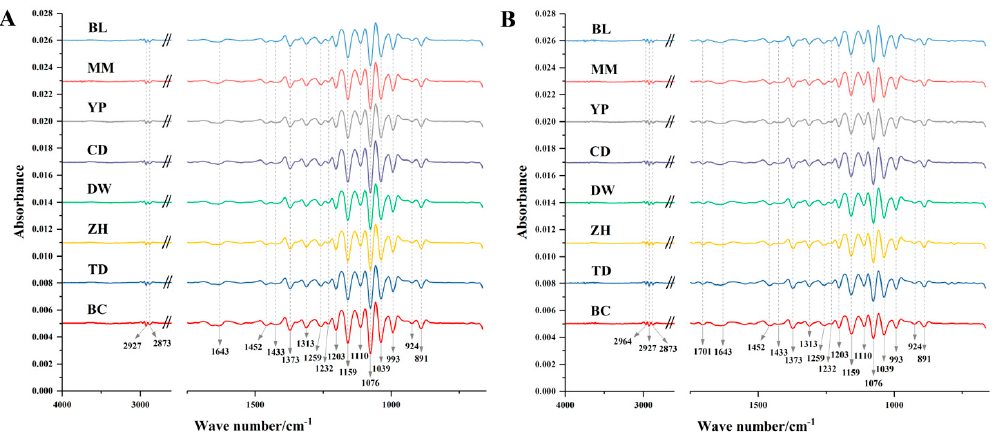
Figure 1. Second derivative spectra of Poria ( A ) and Poriae Cutis ( B ) samples from eight geographic origins. Absorption bands at 2964 and 1704 cm − 1 were just observed in Poriae Cutis